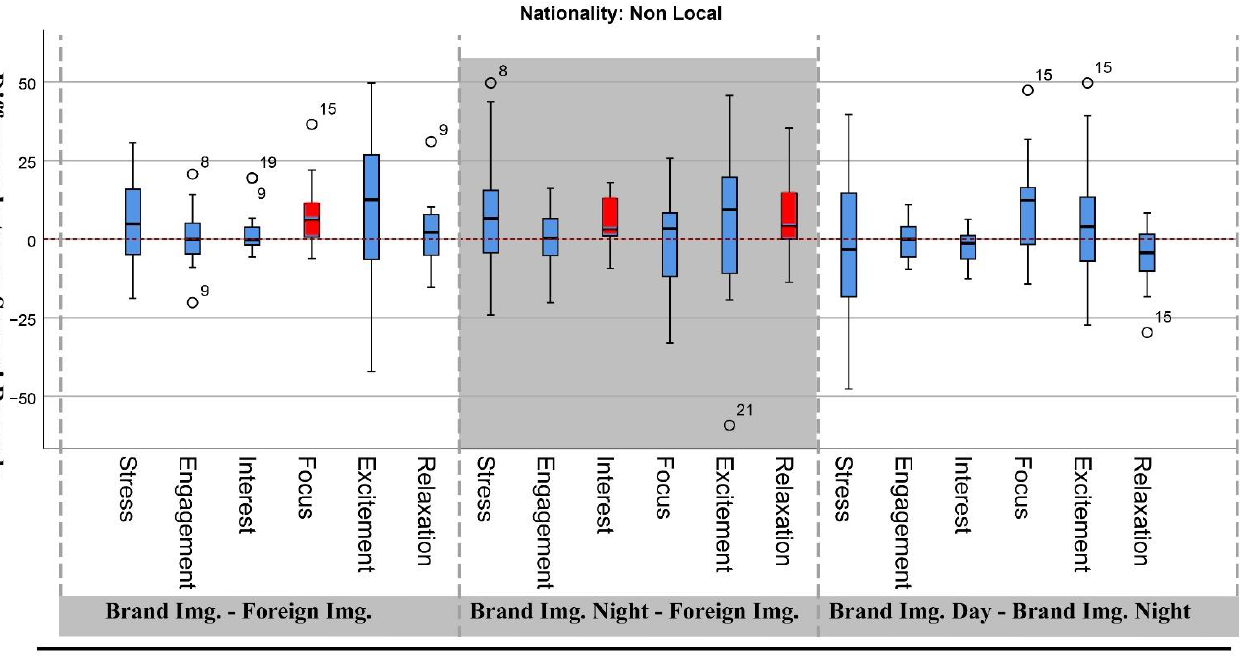
Figure 4. Wilcoxon analysis of EEG data from nonlocals.